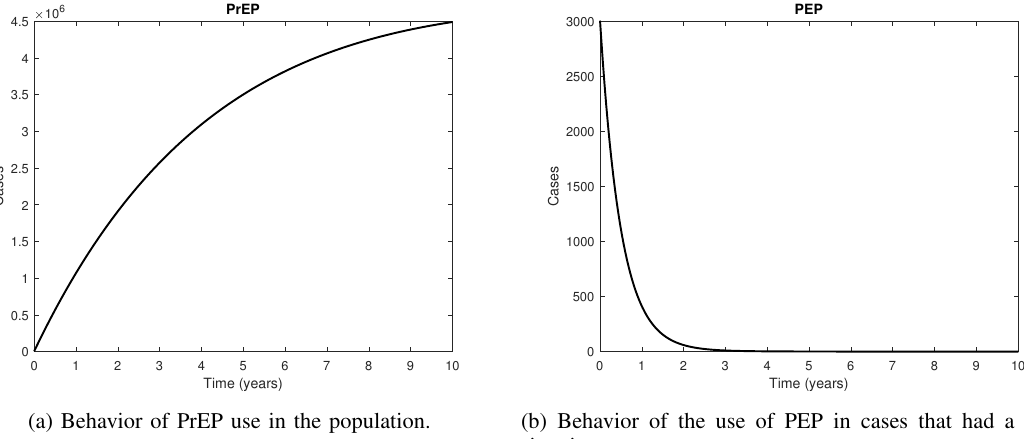
(b) Behavior of the use of PEP in cases that had a risky situation. Fig. 3: PrEP and PEP use in the population for the values presented in Tables I-II, for 10 years of study.